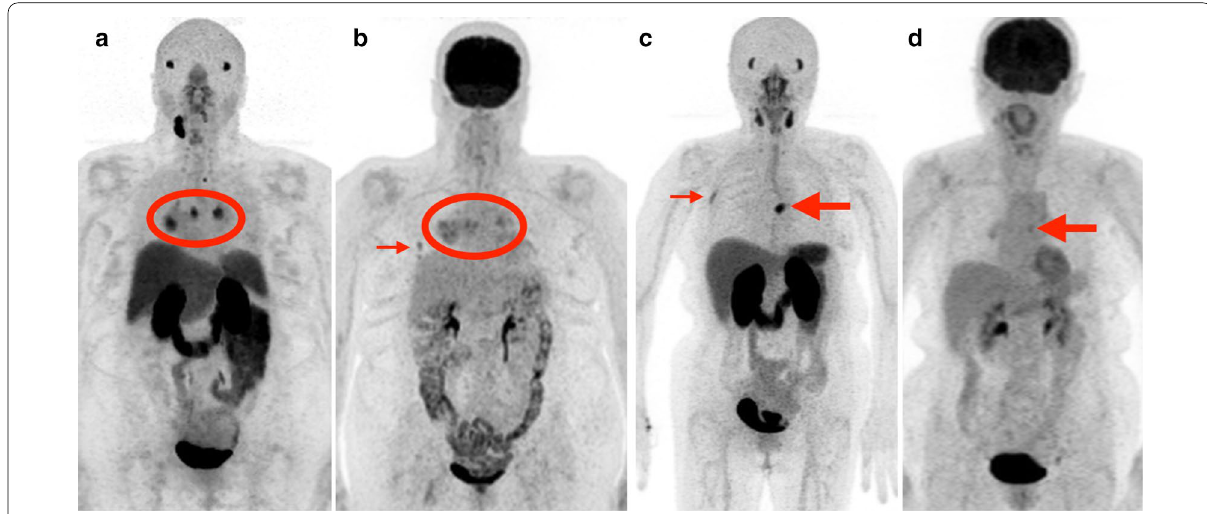
Fig. 3 Patients with metastatic thyroid cancer with greater PSMA uptake than FDG uptake: examples. a , b [ 68 Ga]Ga‑PSMA‑11 PET MIP ( a ) and 2‑[ 18 F] FDG PET MIP ( b ) in a patient (Patient 6) with poorly differentiated papillary thyroid carcinoma. Bilateral hilar and mediastinal metastases (circled) are more avid on PSMA (median SUVmax 8.5) than FDG (median SUVmax 4.1). However, a small right middle lobe metastasis seen on FDG (B, small arrow) is not visible on PSMA. C–D: [ 68 Ga]Ga‑PSMA‑11 PET MIP ( c ) and 2‑[ 18 F]FDG PET MIP ( d ) in a patient (Patient 5) with follicular thyroid carcinoma. A left 8th costovertebral junction metastasis (large arrows) is more avid on PSMA (SUVmax 15.0) than on FDG (SUVmax 3.5). In addition,